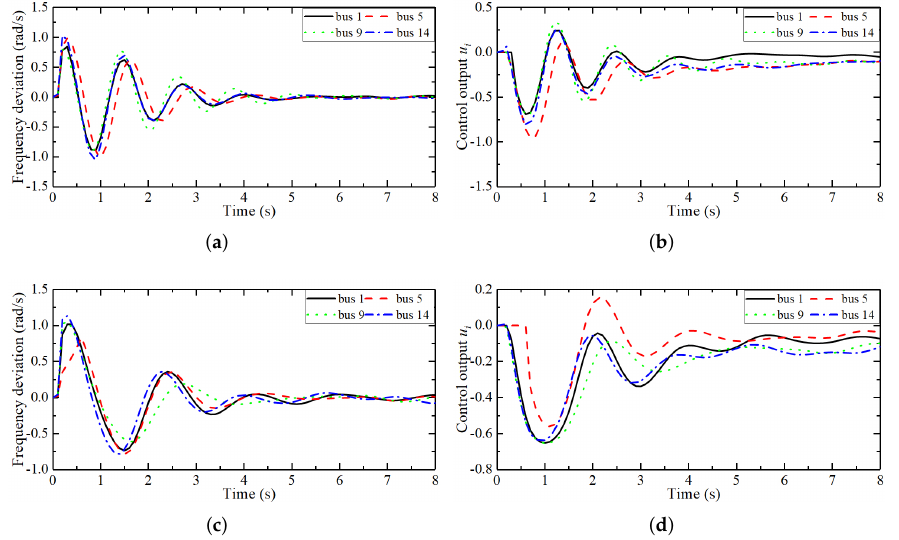
Figure 17. Frequency deviation curve and control output curve, u lim = 2.0 and u lim = 0.8. ( a ) Fre- quency deviation curves, u lim = 2.0. ( b ) Control output, u lim = 2.0. ( c ) Frequency deviation curves, u lim = 0.8. ( d ) Control output, u lim =